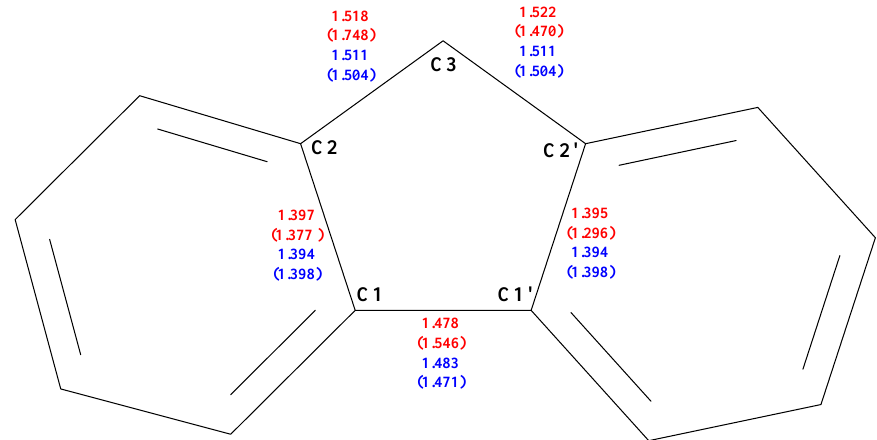
Figure 3. The 5-member ring of fluorene and its labeling. The values after geometry optimization are compared with the corresponding values from the X-ray data refinements (in parenthesis) of 1a (in red) and of fluorene alone [17] (in blue).